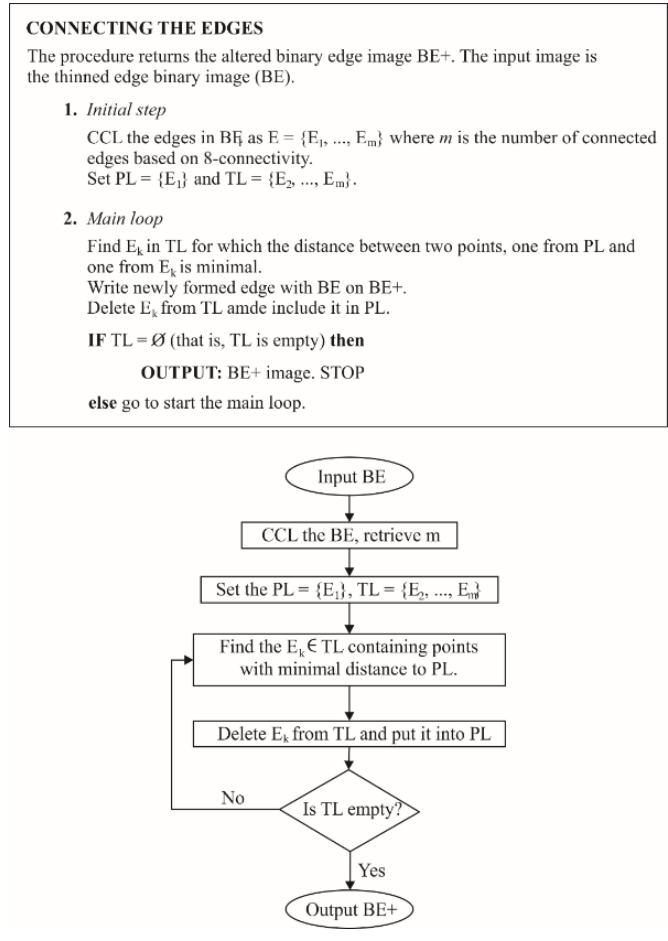
Figure 2. Pseudocode and flowchart of the connecting the edges procedure.